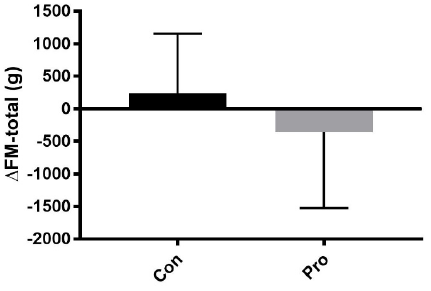
Figure 2. Change in total fat mass (FM) from pre ‐ intervention (Pre) to post ‐ intervention (Post) in control group (Con, n = 9) and protein group (Pro, n = 7). Data are shown as mean ± standard deviation (SD).